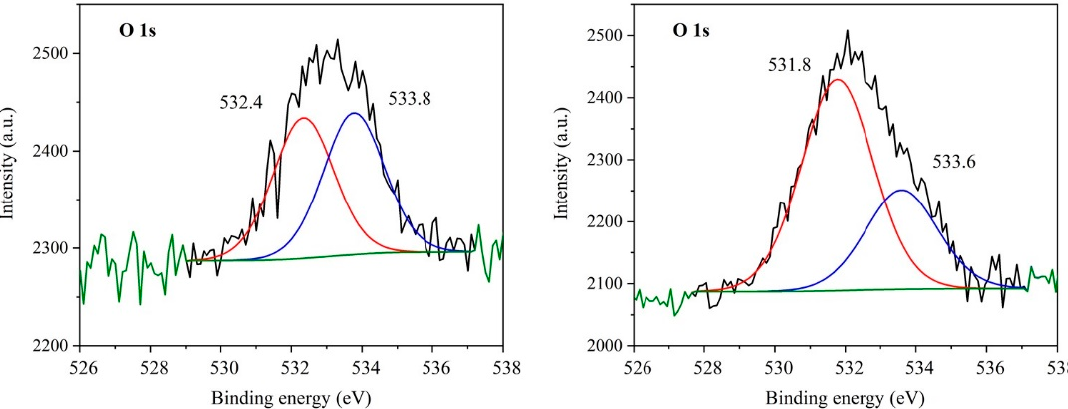
Figure 7. XPS spectra of O 1s of Ex3 ( left ) and Ex3 30 % H 2 O 2 nanomaterials ( right ).